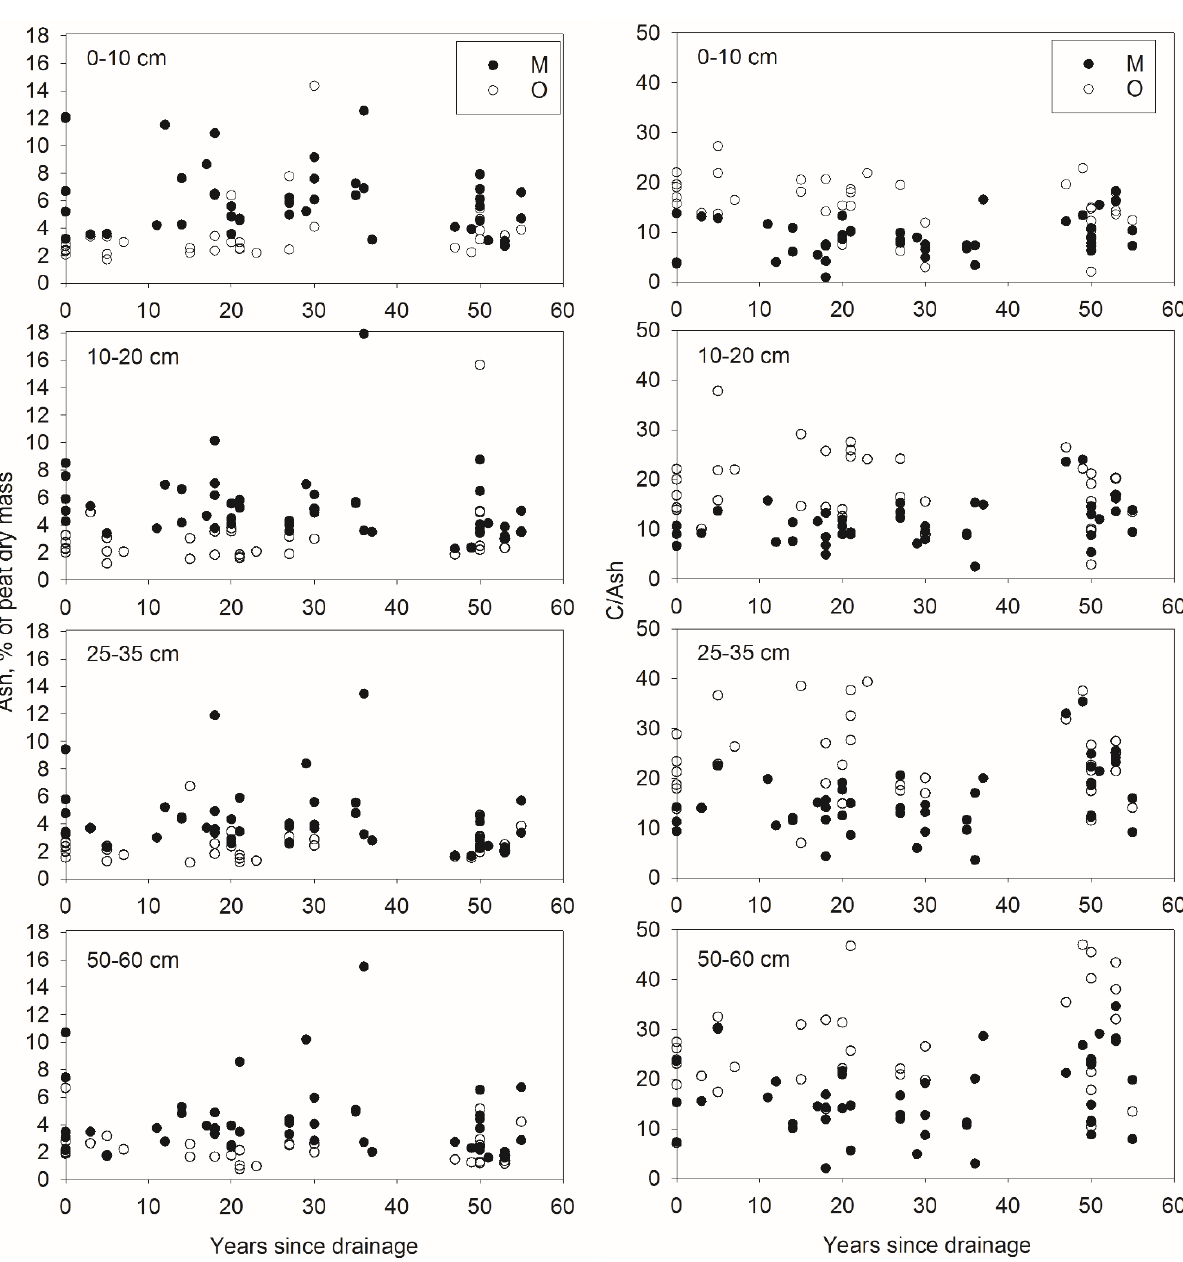
Figure 1. Variation in the ash concentration (% of peat dry mass; left) and the quotient of C and ash concentrations (right), at different sampling depths in two site type groups, namely: clearly minerotrophic sites (M), and ombrotrophic or transient (O) sites. Undrained sites (years since drainage = zero) and sites drained for forestry at different times were included. From the material of Laiho & Laine (1994, 1995); Laine et al. (1995a) and Laiho et al. (1999) utilised the same material. The M sites (n = 45) were meso- oligotrophic sparsely treed sedge fens with Carex peat, and the O sites (n = 37) were ombrotrophic pine bogs and transient sparsely treed sites with oligotrophic Sphagnum peat. In the ash panels, the following extreme values were excluded: layer 0–10 cm - a value of 35.3 for an M site drained 18 years before measurements, and a value of 19.6 for an O site drained 50 years before measurements; layer 50–60 cm - a value of 22.4 for an M site drained 18 years before measurements. In the panel for C/ash, layer 50–60 cm, the maximum value of 63.1 for an O site drained 21 years before measurements was